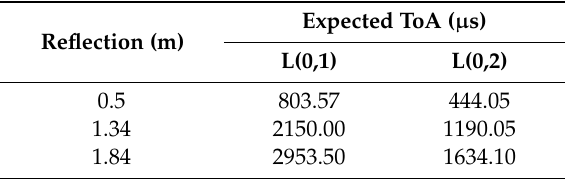
Table 2. Calculated time-of-arrival (ToA) for the expected reflections from pipe ends at 16 kHz operating